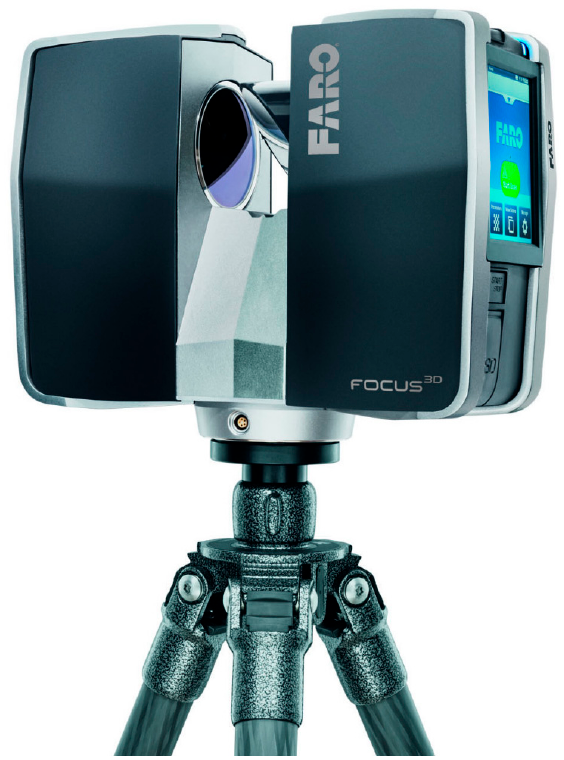
Figure 2. Scanner FARO Focus 3D [30].